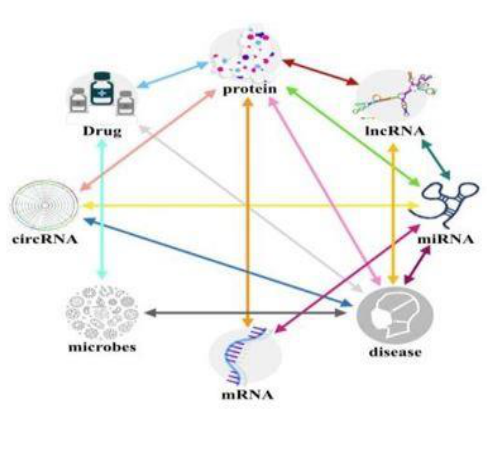
Figure 1. Disease and drug